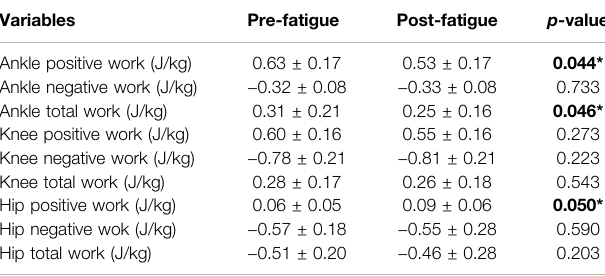
TABLE 5 | Lower extremity joint work pre-fatigue running and post-prolonged fatigue running (x ± SD).